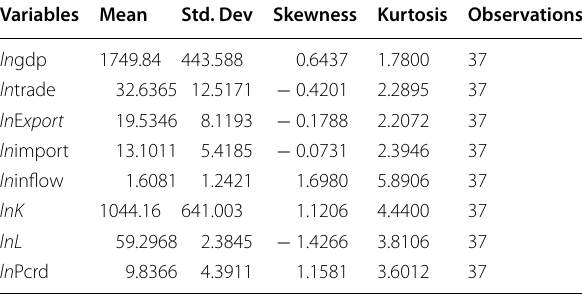
Table 1 Descriptive statistics. Source: author’s